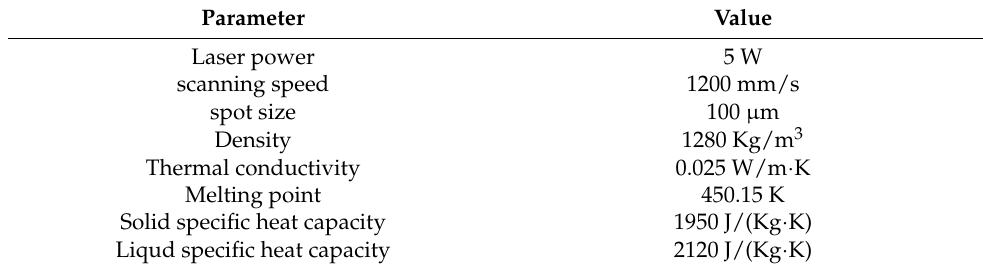
Table 3. The input parameters during FEM